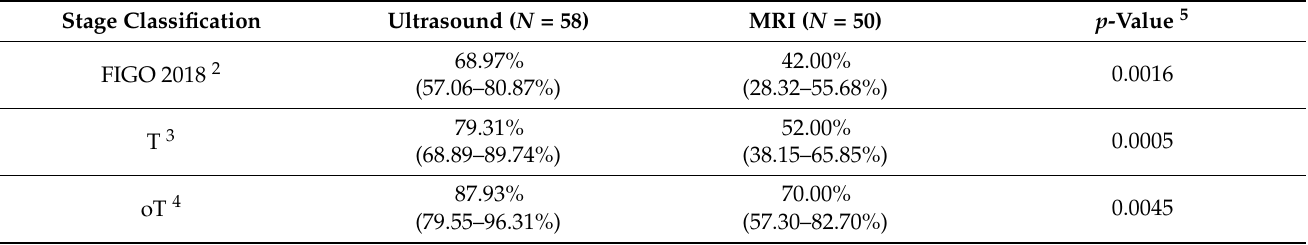
Table 7. Accuracy of ultrasonography and MRI for cervical cancer stage prediction 1 . Stage Classification FIGO 2018